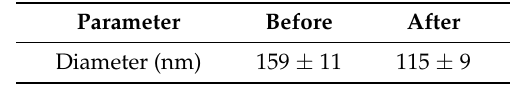
Table 3. Diameters of the electrospun fibers before and after the alkaline